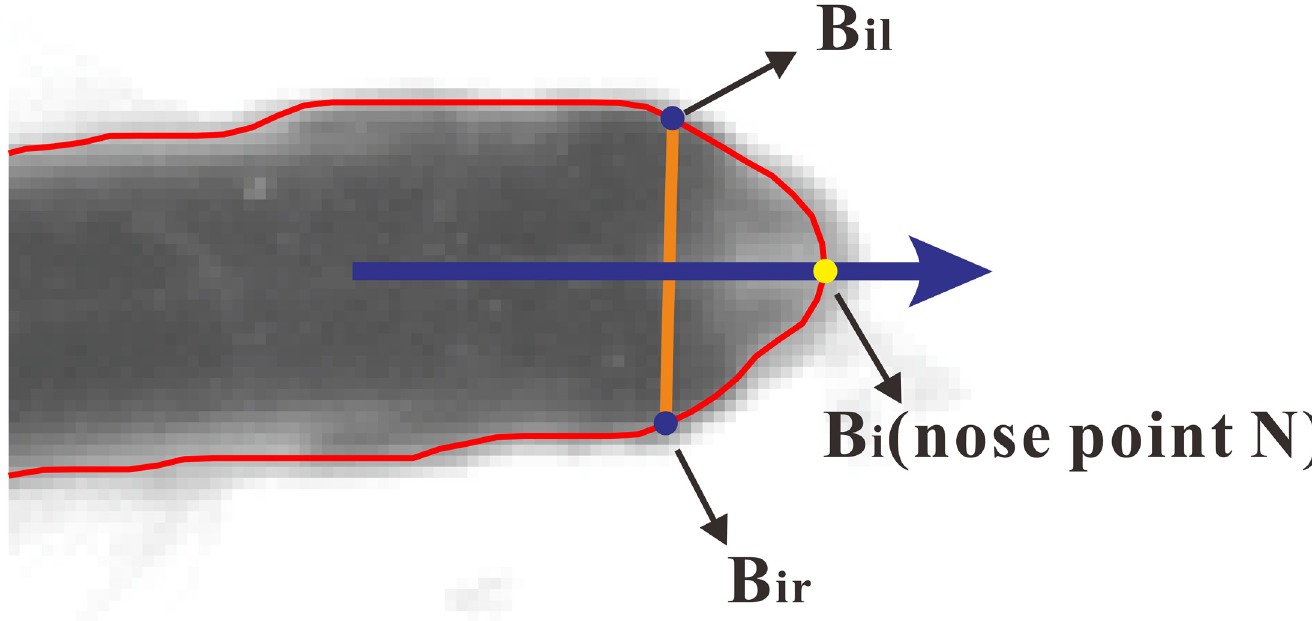
Fig 3. Head orientation computation. N (yellow point) is the detected fish nose point, B il and B ir (blue points) are points on the left and right side of N on the fish boundary 8 unit arc length away. Blue arrow indicates the orientation of